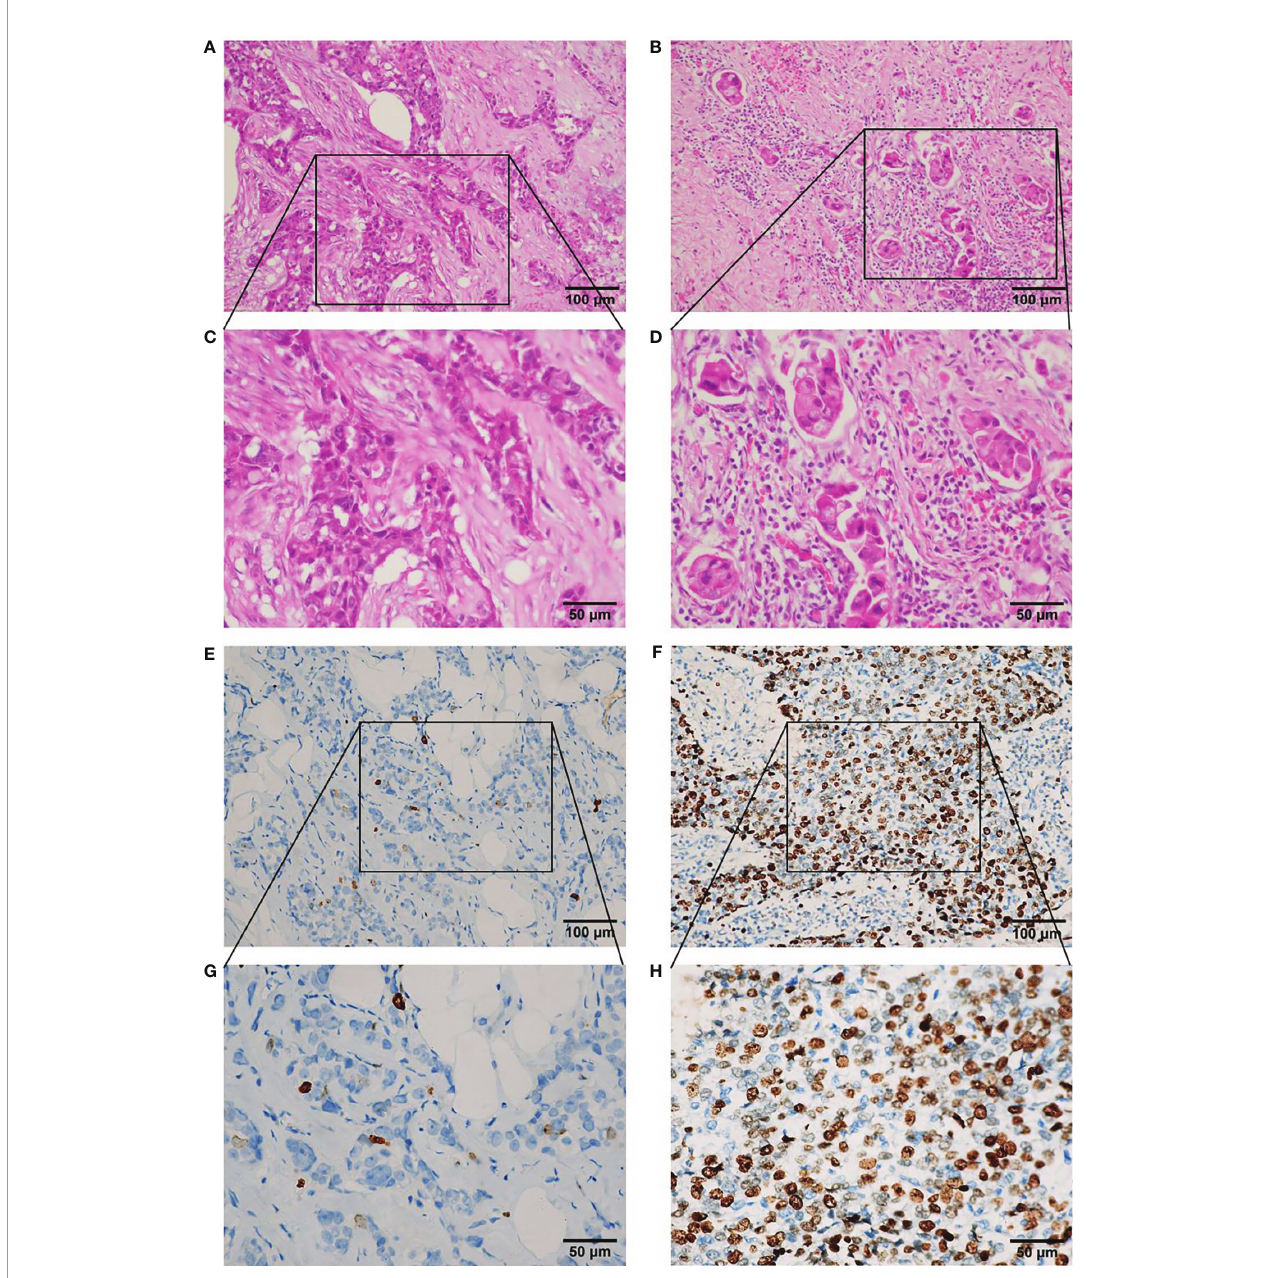
FIGURE 2 | Representative photomicrographs of TILs in hematoxylin and eosin sections and Ki67 index in immunohistochemical sections in residual disease in triple-negative breast cancer after neoadjuvant chemotherapy. (A) Low level (<30%) of TILs (×200 magni fi cation). (B) High level ≥ 30%) of TILs (×200 magni fi cation). (C) Low level (<30%) of TILs (×400 magni fi cation). (D) High level ( ≥ 30%) of TILs ( x 400 magni fi cation). (E) Low level (<14%) of Ki67 index (×200 magni fi cation). (F) High level ( ≥ 14%) of Ki67 index (×200 magni fi cation). (G) Low level (<14%) of Ki67 index (×400 magni fi cation). (H) High level ( ≥ 14%) of Ki67 index (×400 magni fi cation). TILs, tumor-in fi ltrating